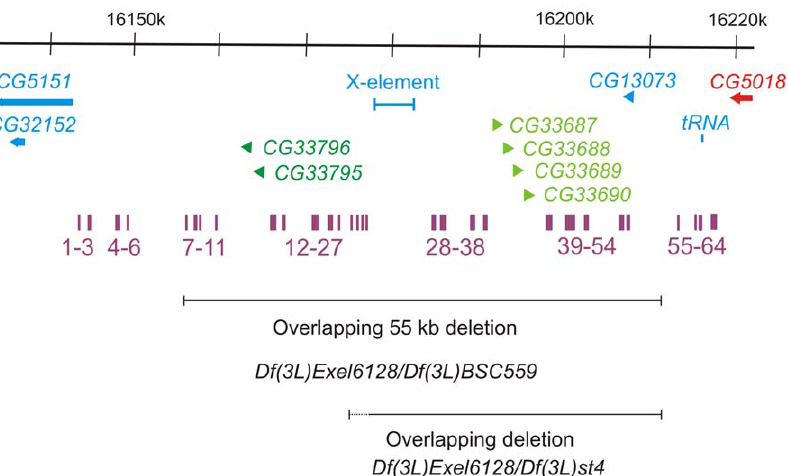
Figure 3. Molecular map of the , 80 kb genomic region between CG5151 and CG5018 . The approximately 80 kb of genomic DNA (from 3L: 16140k to 16220k, Release 5.23) is represented by the horizontal black arrow at the top. The predicted transcription units are represented by colored thick horizontal arrows. The essential transcription unit CG5018 is red. The clusters of transcription units predicted to encode related proteins are dark green and light green. All other transcription units are blue. The transposable X-element (shown by the blue bar) is present in the iso-1 strain, but not in Canton S. The highly conserved DNA sequences are represented by the purple bars in the middle. Below each cluster of conserved sequences are the numbers corresponding to Table S1. The DNA sequences missing in flies trans-heterozygous for the overlapping deletions Df(3L)Exel6128 and Df(3L)BSC559 , or Df(3L)Exel6128 and Df(3L)st4 are indicated by the horizontal black bars at the bottom. The dotted line at the left of the Df(3L)Exel6128/ Df(3L)st4 black bar indicates the 3kb region to which the distal breakpoint of Df(3L)st4 was